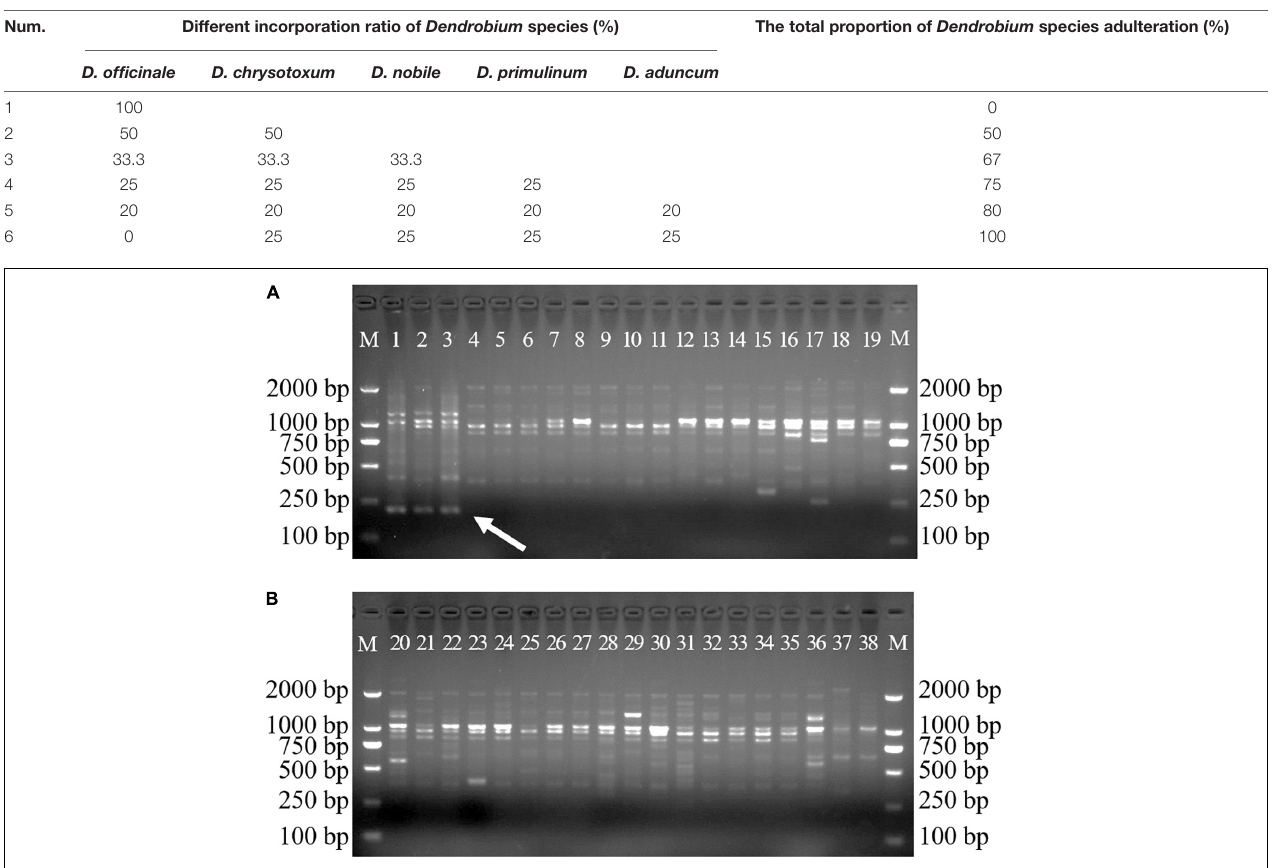
FIGURE 1 | SCoT13 profiles of different Dendrobium species. Two 1.5% agarose gels were used for 38 Dendrobium species electrophoresis analysis (A,B) . Lane 1 ∼ 38: Details of 38 Dendrobium species are provided in Table 1 . Lane M: Trans2K DNA Marker with lengths (bp); Arrowheads represent specific amplified bands in all the D. officinale